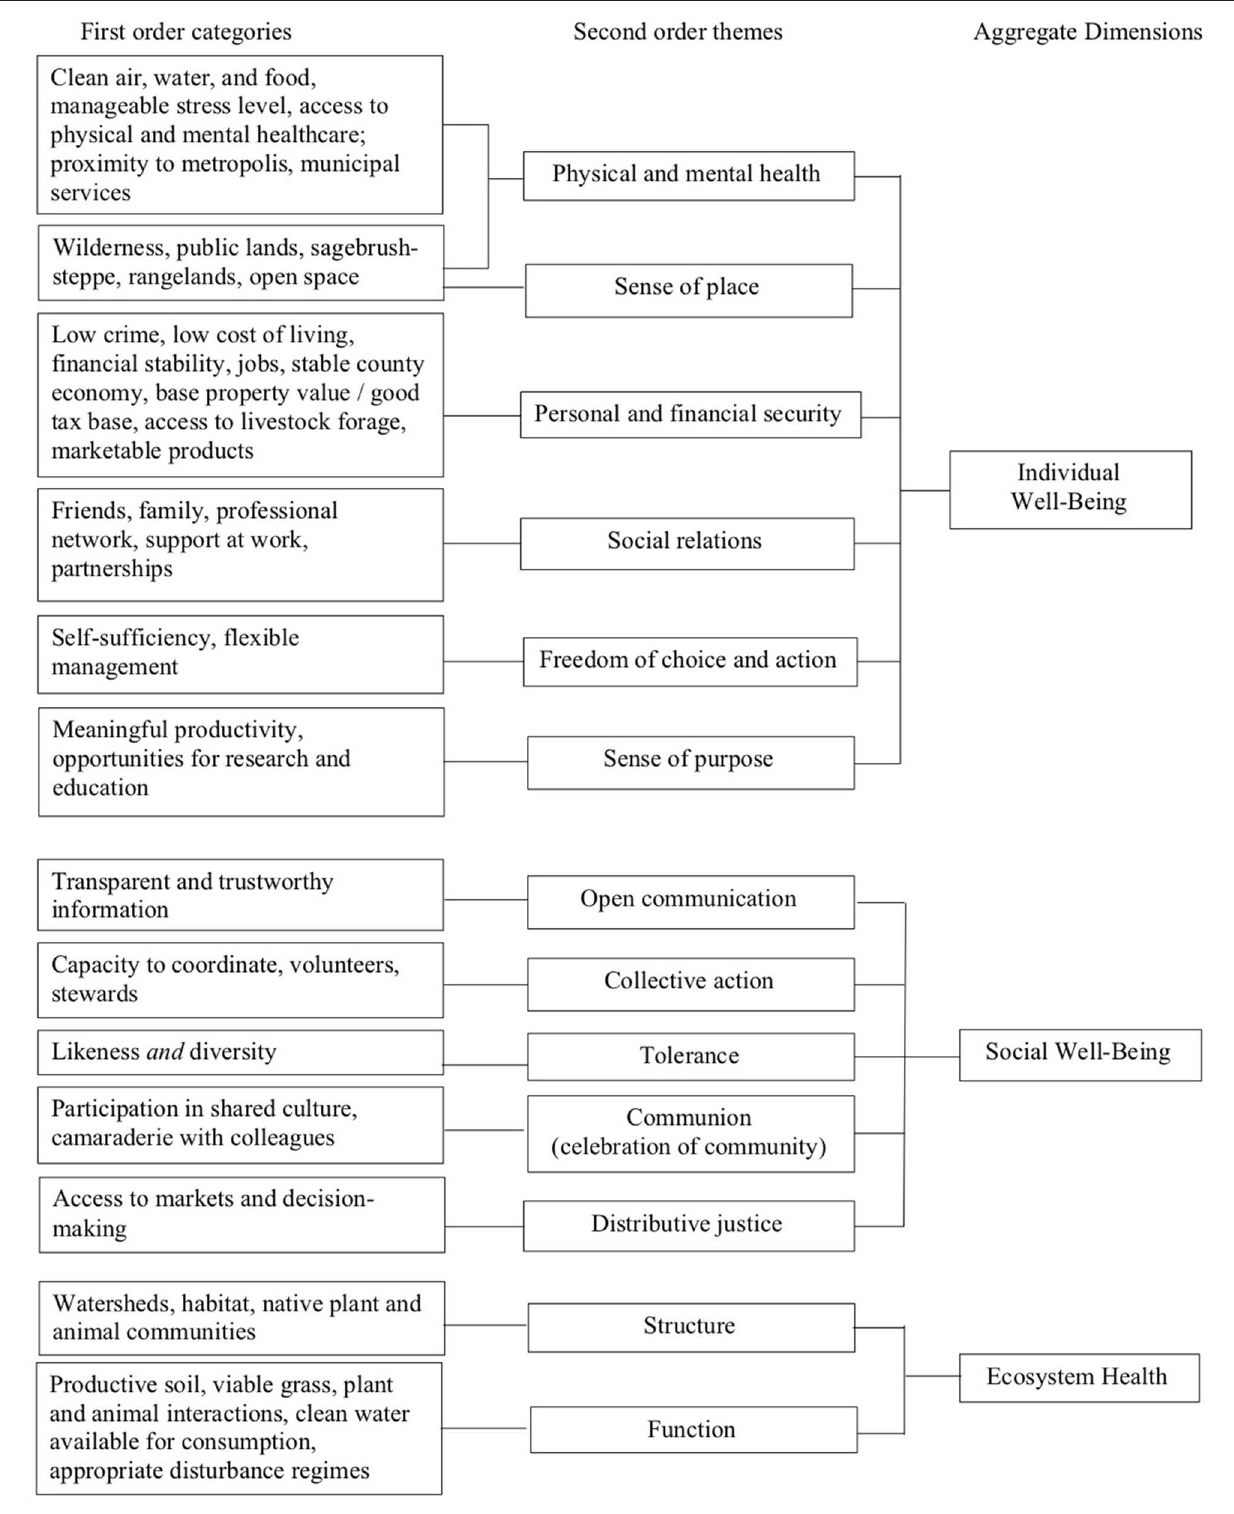
Frontiers in Sustainable Food Systems |